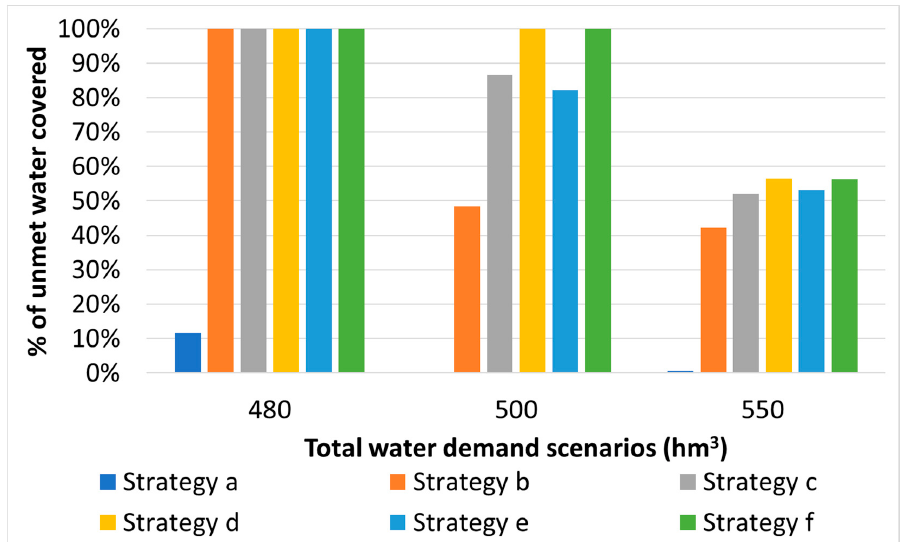
Figure 6. % decrease of unmet water demand for the selected water supply time series 4, each failed water demand scenario, and each water demand management strategy.